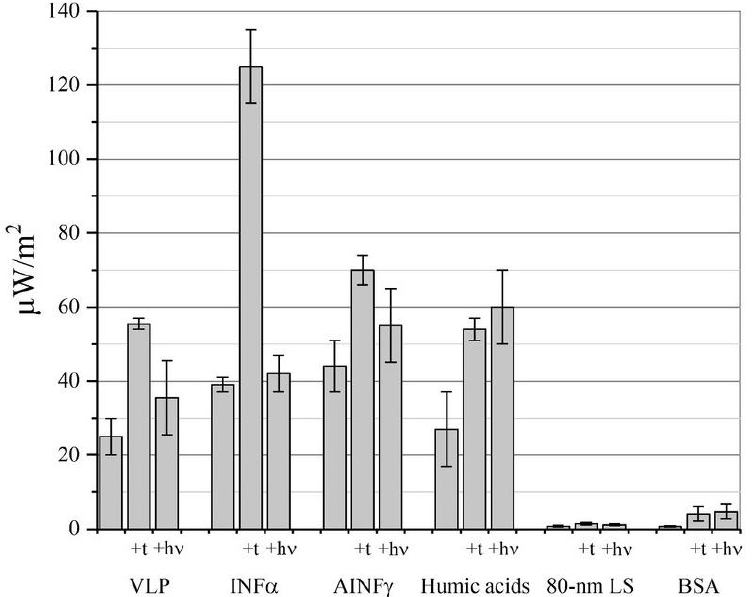
Figure 2. The power density of thermal radio emission of nanoparticle solutions (VLP of rotavirus, INF-α, humic acids, and latex spheres (LS)) and powders containing nanoparticles (AINF-γ and BSA). The data are shown at 23 °С and 37 °С (+t) and irradiation at λ = 412 nm (+hν) (SD, n = 9, p >